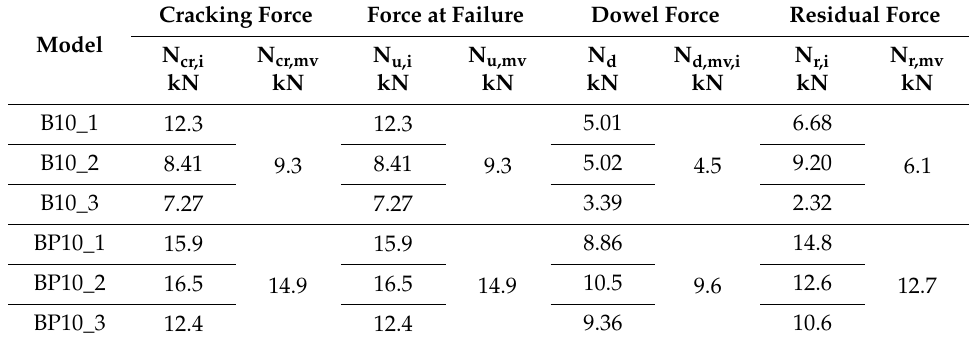
Table 9. Test results for reinforced joints (forces).